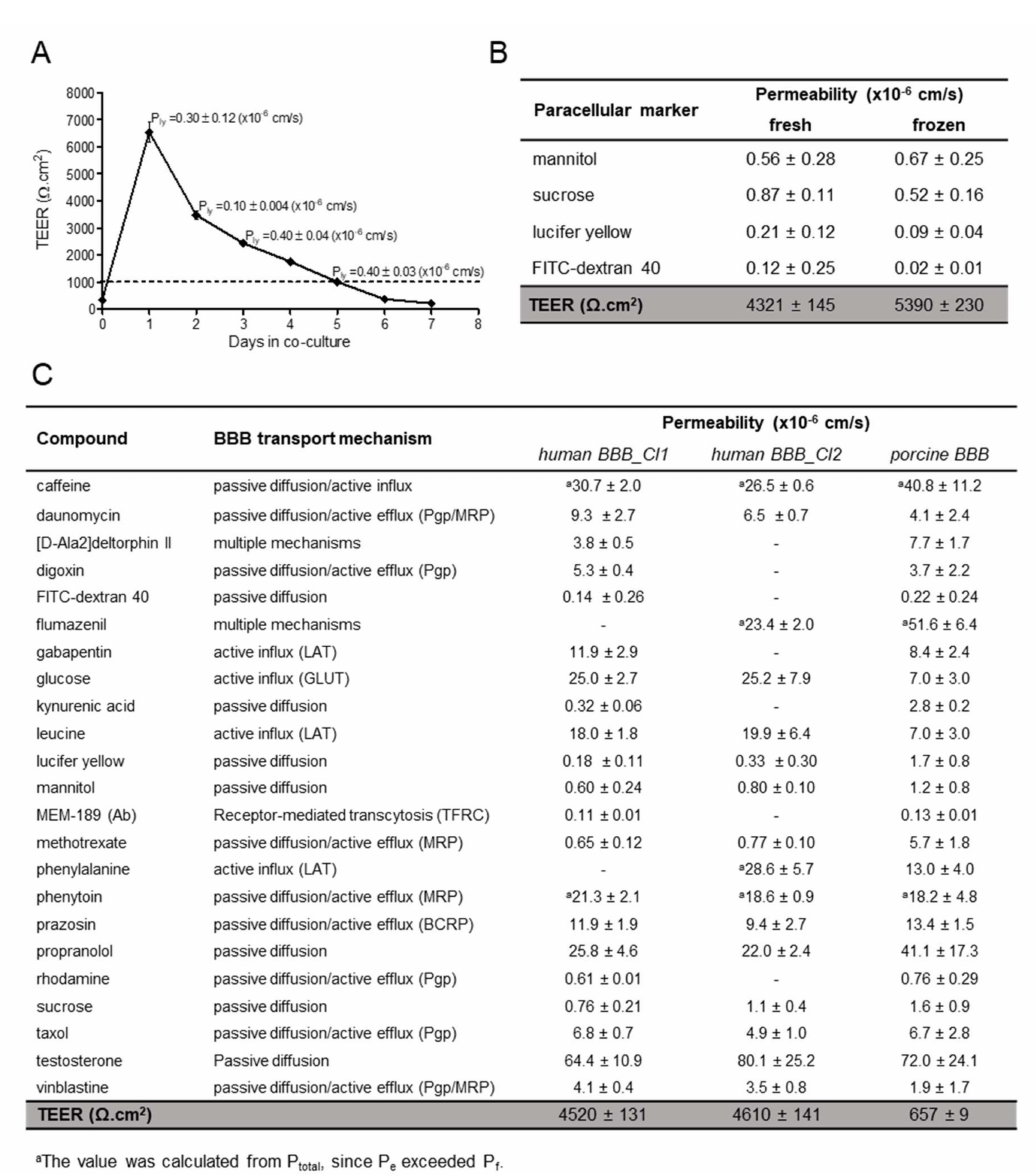
Figure 5. TEER and Permeability. ( A ) TEER measurements in hiPSC-derived BMECs (Cl1) were performed one day after seeding onto Transwells, just before co-culture with human astrocytes (d0) and every day thereafter, n = 3. Permeability values of the paracellular marker lucifer yellow were determined in triplicates and expressed as mean ± sd. ( B ) Paracellular markers permeability and TEER values at d1 co-culture in hiPSC-derived BMECs (Cl1) from fresh and frozen sources (cryopreserved at D8 of di ff erentiation). Values of permeability are the mean ± sd from at least one determination with 3 biological replicates. TEER value is the mean ± SEM, with N = 96 (fresh) and N = 22 (frozen). ( C ) Summary of the permeability values in the in vitro human (Cl1 and Cl2) and porcine BBB models of compounds with di ff erent transport mechanisms. Values are the mean ± sd from at least one determination with 3 biological replicates. TEER value is the mean ± SEM, with N = 118 (Cl1); N = 100 (Cl2) and N = 701 (porcine). Porcine values, except D-Ala-deltorphin II, flumazenil and MEM-189, were previously reported